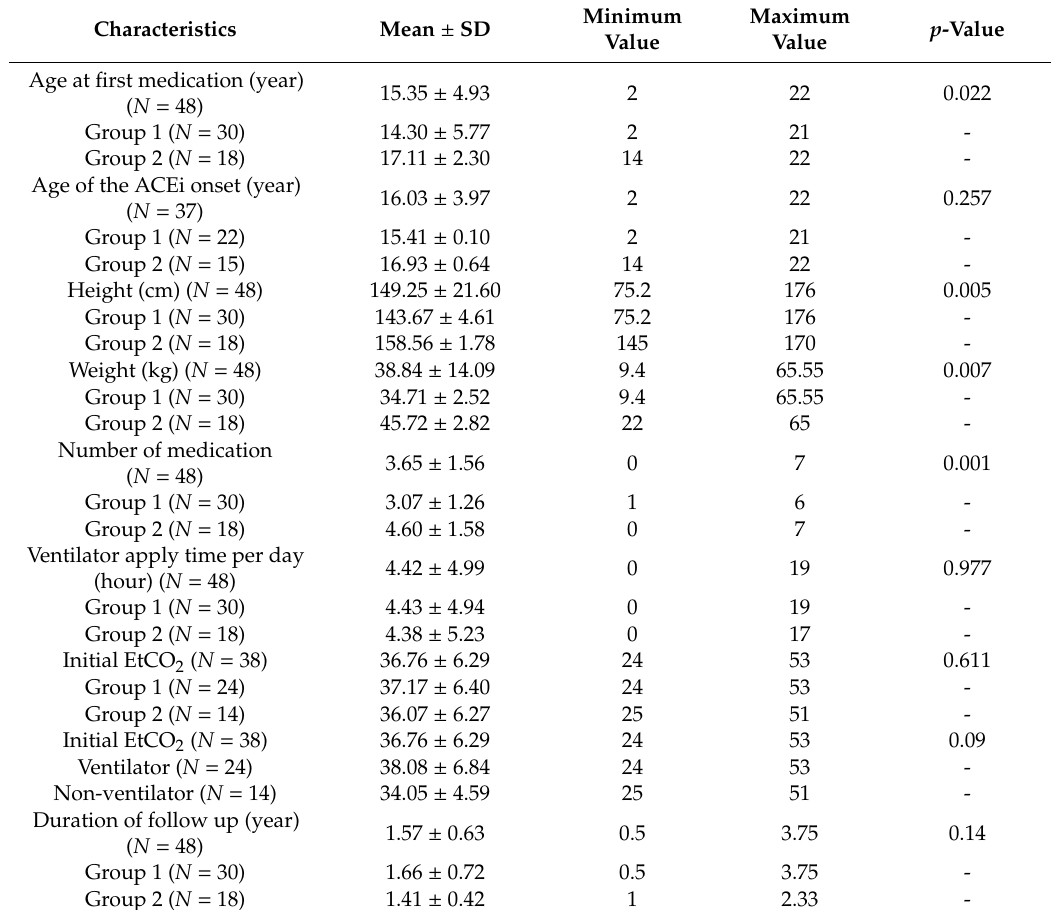
Table 1. Demographic characteristics of patients with Duchenne muscular